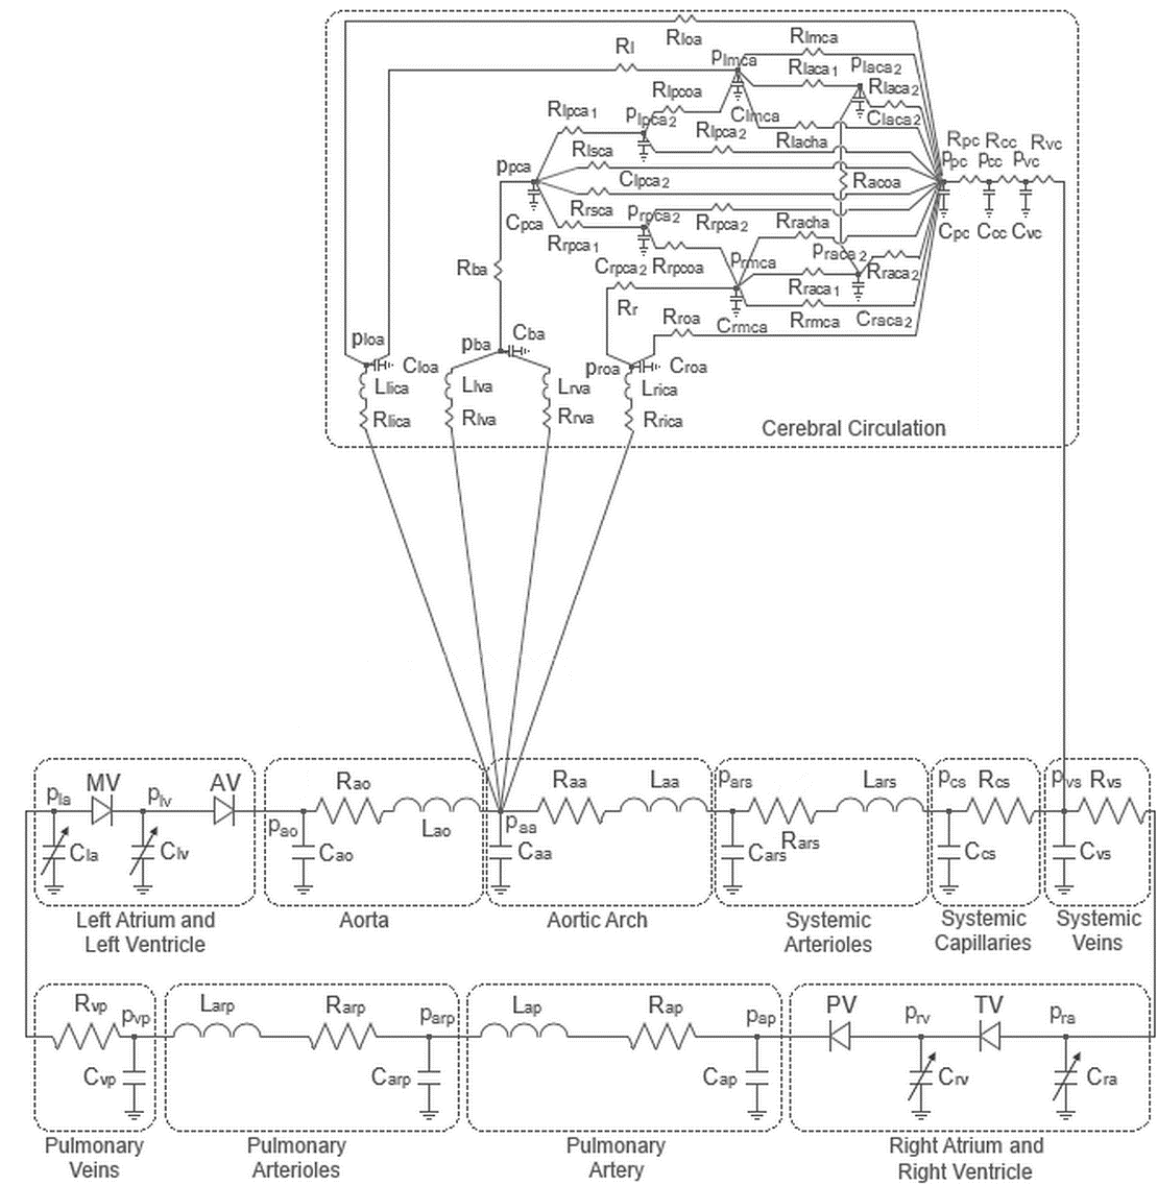
Figure 1. Circuit diagram representation of the cardiovascular system model. The parameter values used in the cerebral circulatory system for stages of Moyamoya Supplementary Table S4 for the child cardiovascular system model. Parameter values